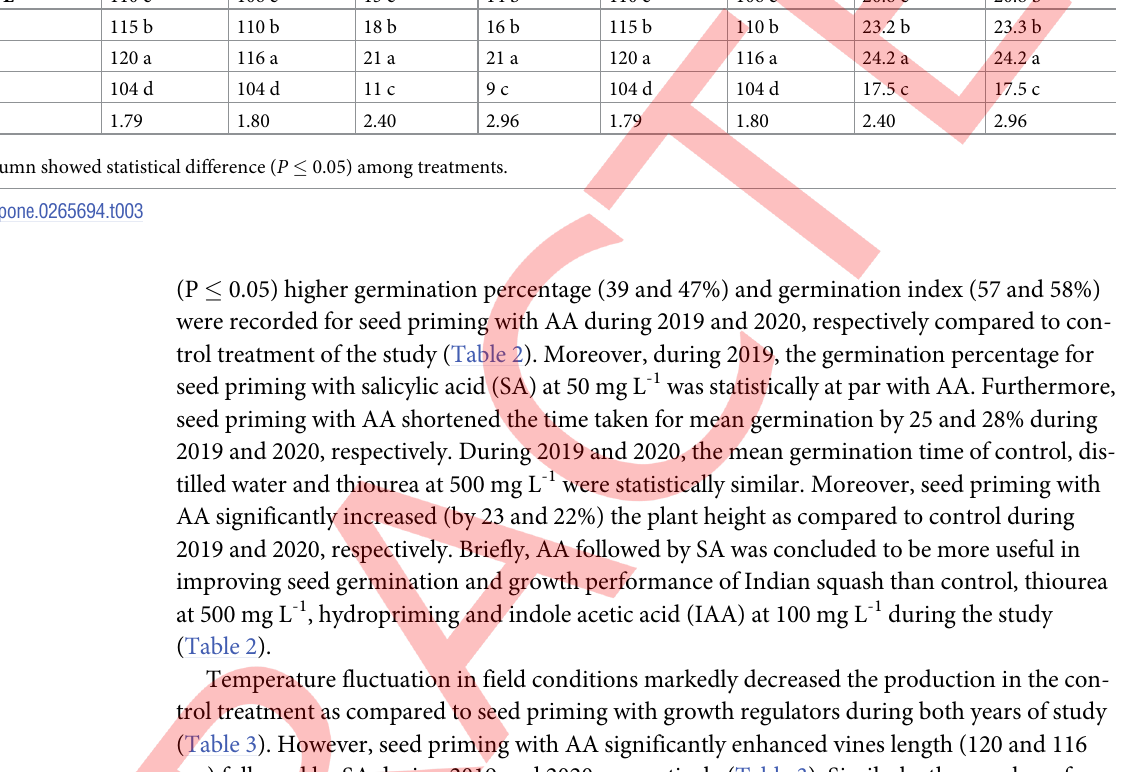
ments. Seed priming with AA significantly enhanced the photosynthesis rate (3.84 and